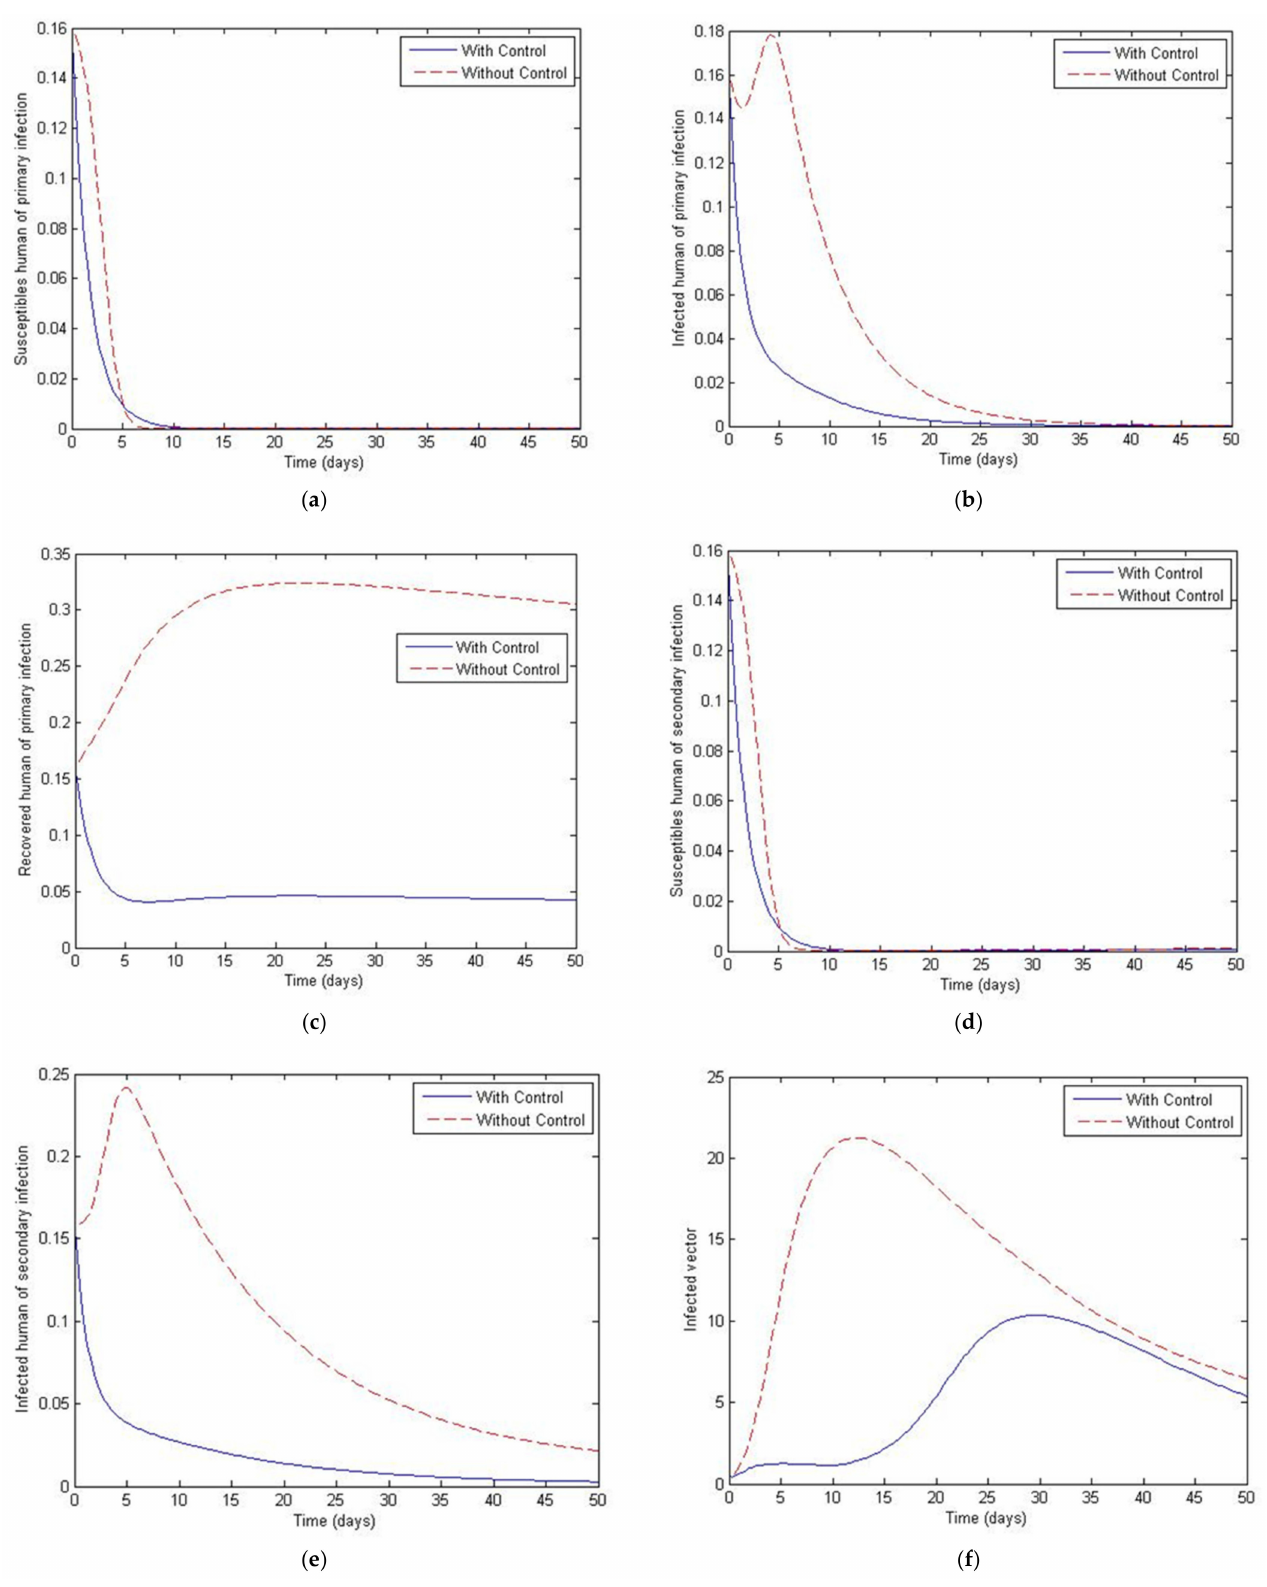
Figure 12. Simulation results of system of Equations (38)–(43) with and without controls of S HP , I HP , R HP , S HS , I HS and I V with X 1 = 50, X 2 = 100. ( a ) Susceptibles of primary infection ( b ) Infected population with primary infection ( c ) Recovered human of primary infection ( d ) Susceptibles of secondary infection ( e ) Infected human of secondary infection ( f ) Infected